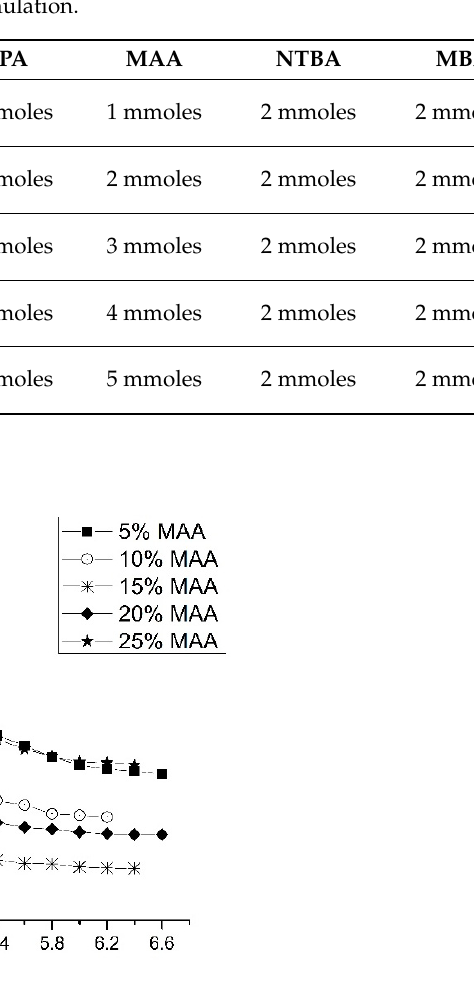
Figure 6. pH response profile for a series of NIPA–MAA copolymers prepared with increasing MAA content.